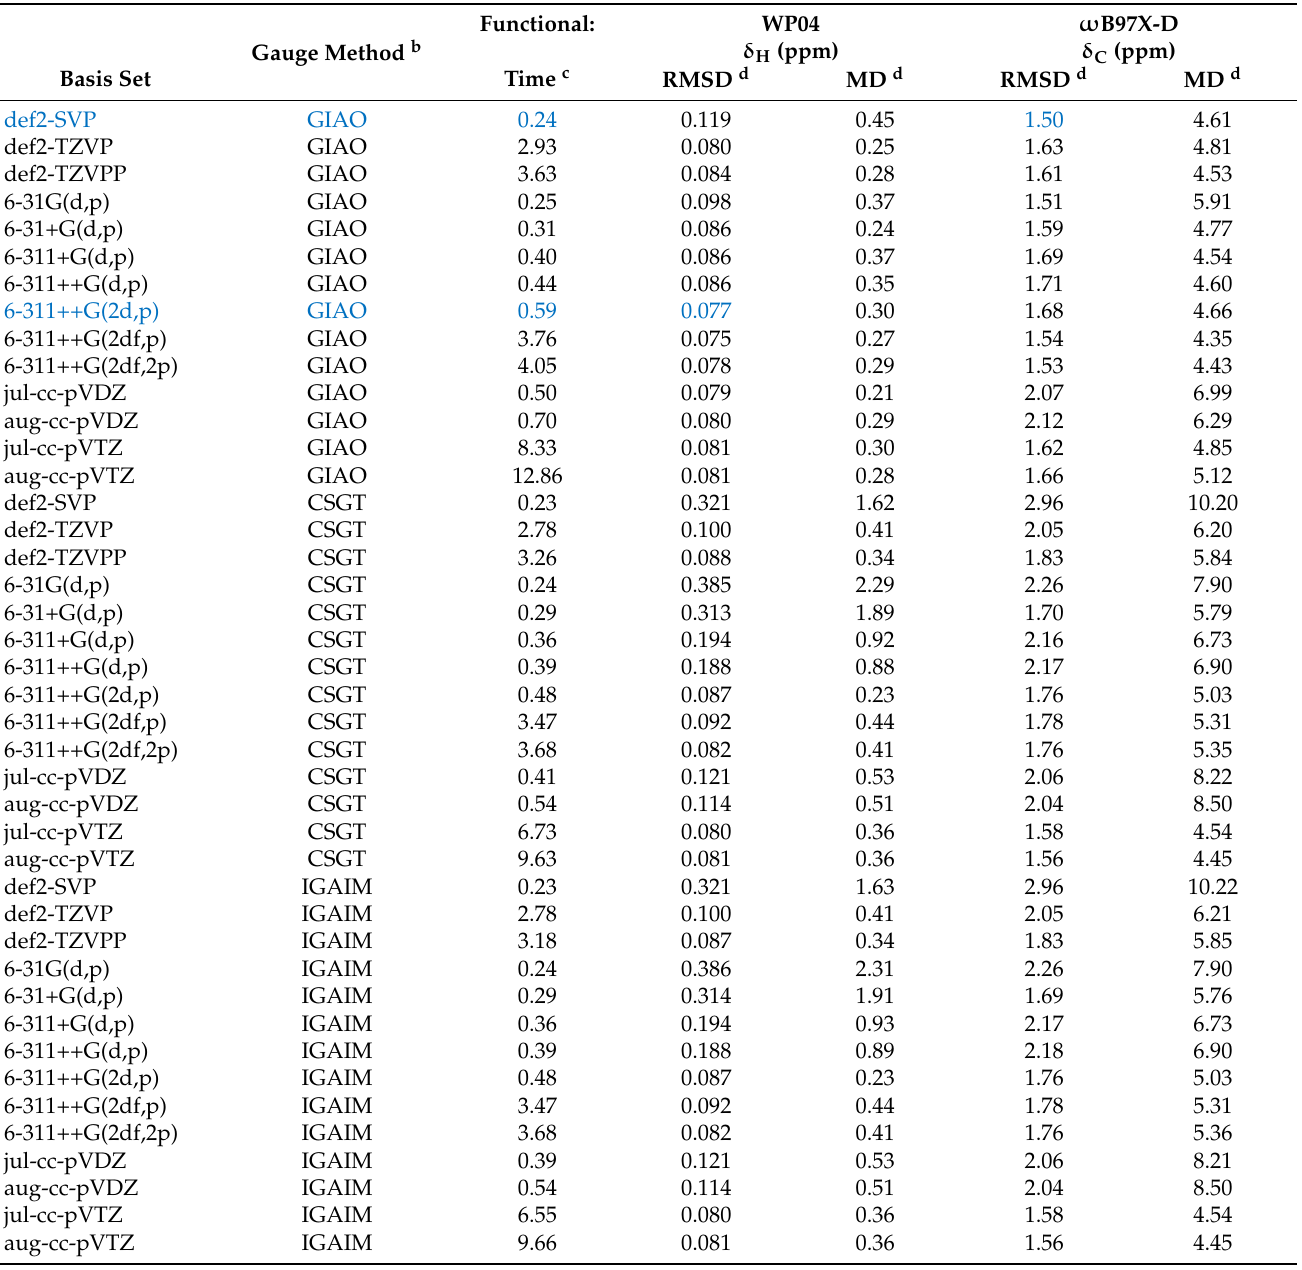
a Calculations using gas phase B3LYP/6-31G(d) geometries and PCM (chloroform) solvent model b Recommended gauge method highlighted in blue, bold font. c Relative time for PCM- ω B97X-D calculation of nitromethane with specified basis set. d RMSD = root-mean-square deviation; MD = maximum